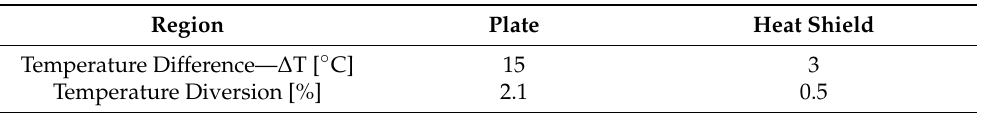
Table 3. Temperature experiment: temperature difference ( ∆ t) in the two different pressure experi- ments (temperature at 10 − 2 —temperature at 10 − 3